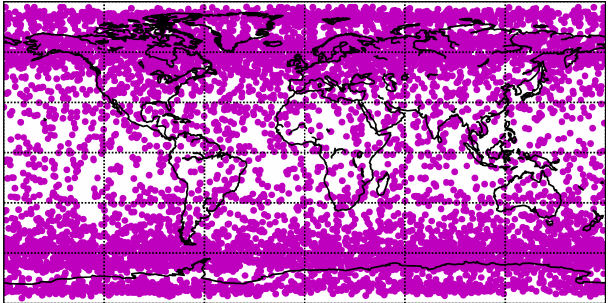
Figure 5. Distribution of MIPAS ESA v8 and ACE-FTS v.3.5 matching